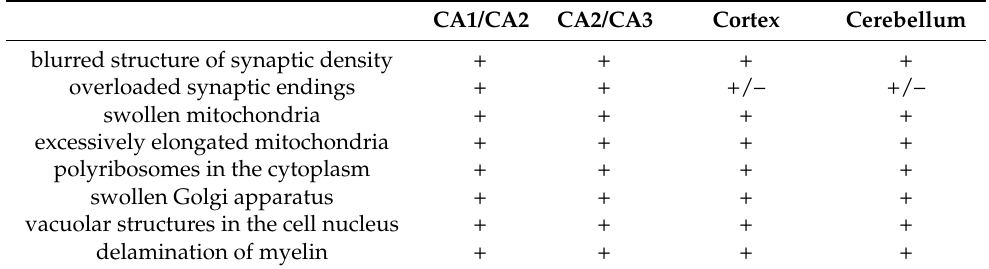
Table 3. Pathological alterations of neuronal ultrastructure found in the brains of Tsc2 +/ − mice. CA1/CA2 CA2/CA3 Cortex Cerebellum blurred structure of synaptic density overloaded synaptic endings